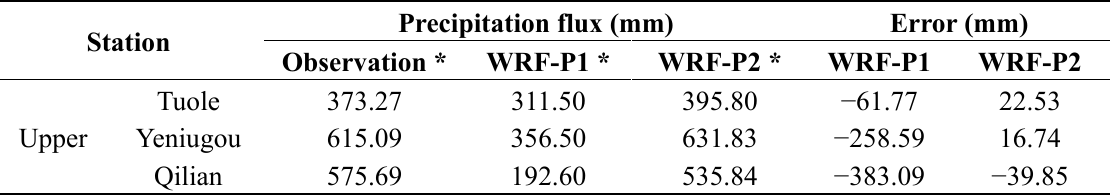
Figure 2. Error analysis for the precipitation between the WRF model and observations: ( a ) and ( b ) are scatterplots of the precipitation between the WRF simulation and observations at annual and monthly scales; ( c ) and ( d ) are charts showing the error range of precipitation yielded by WRF model at daily and hourly scales. Table 3. Error bias analysis between two physical parameterization sets evaluated using 2008 annual precipitation.